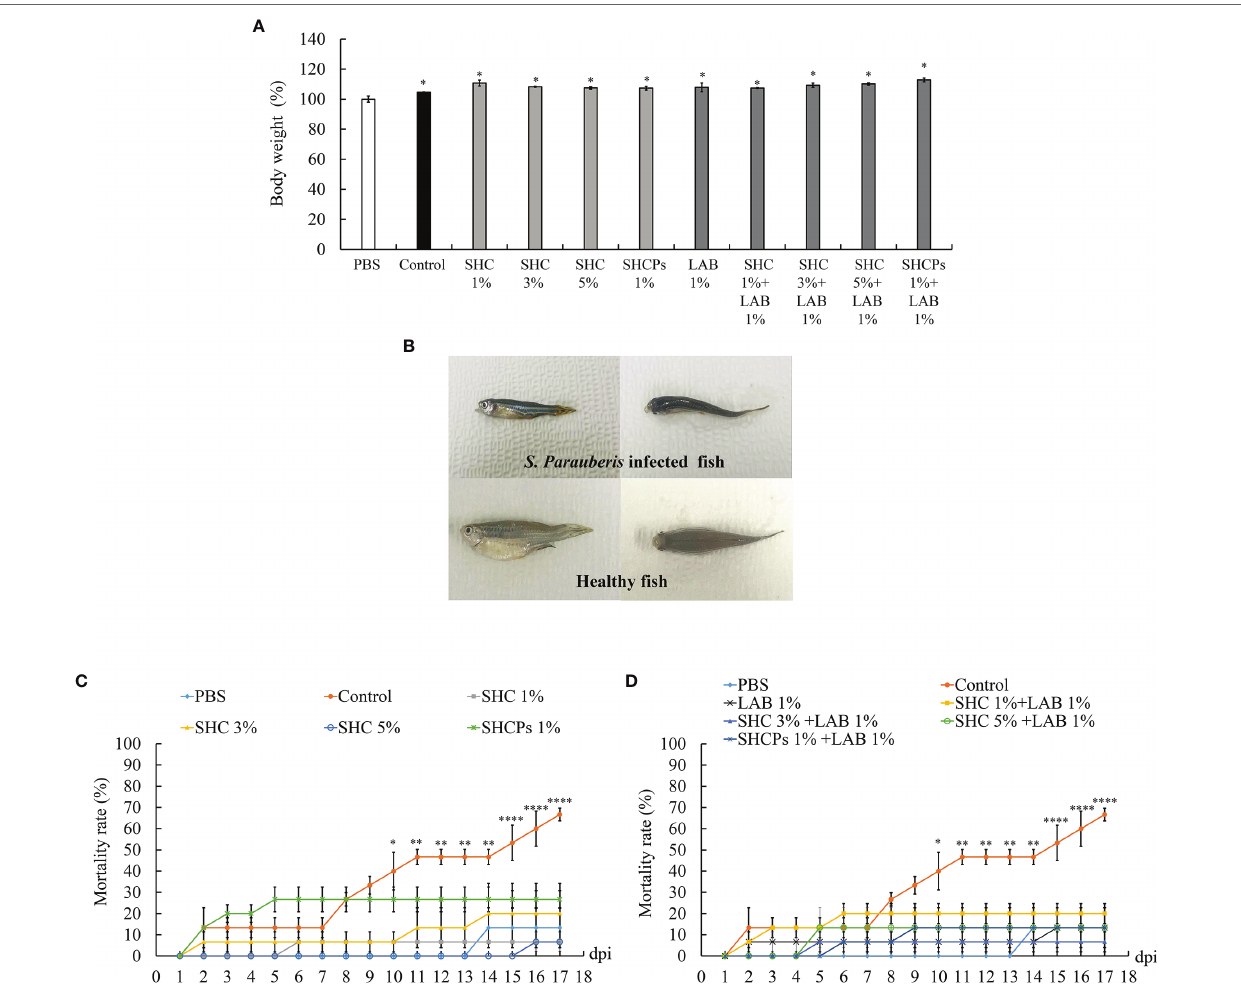
FIGURE 4 | Effect of experimental diet on S. parauberis infected zebrafish. (A) growth performance of zebrafish, (B) morphology, (C) accumulated mortality (diet containing SH extracts only), and (D) accumulated mortality (diet containing LAB and SH extracts). Statistical evaluation was performed to compare the experimental and control groups. Values are significantly different from PBS group at *p<0.05, **p<0.01, and ****p<0.0001.